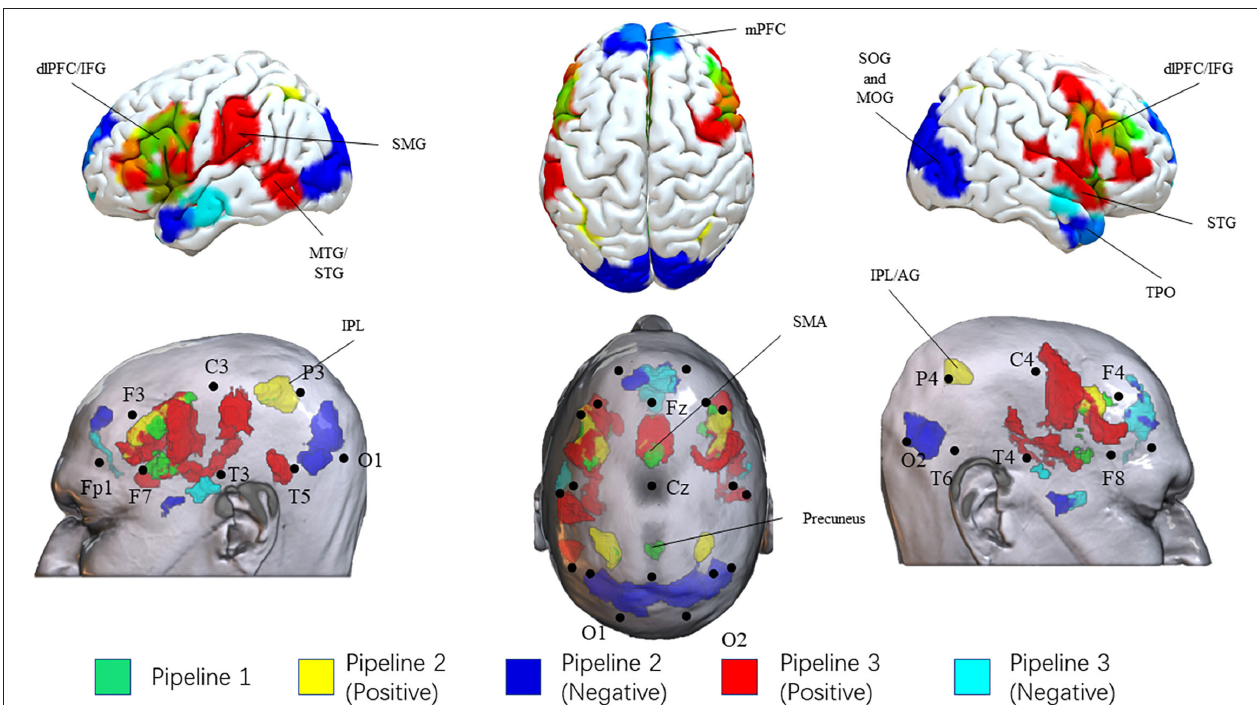
FIGURE 2 | Results of three pipelines. Brain surface regions identified from the three pipelines were presented on the top. Scalp locations corresponding to the brain surface regions were presented on the bottom. Results from pipeline 1, pipeline 2 (positive correlation), pipeline 2 (negative correlation), pipeline 3 (positive correlation), pipeline 3 (negative correlation) were presented as green, yellow, blue, red, and cyan, respectively. L, left; R, right; IPL, Inferior Parietal Lobule; AG, angular gyrus; SMG, supramarginal gyrus SMA, supplementary motor area; dlPFC, dorsolateral prefrontal cortex; IFG, inferior frontal gyrus; mPFC, medial prefrontal cortex; MTG, middle temporal gyrus; STG, superior temporal gyrus; MTG, middle temporal gyrus; TPO, temporal pole; SOG, superior occipital gyrus; MOG, middle occipital